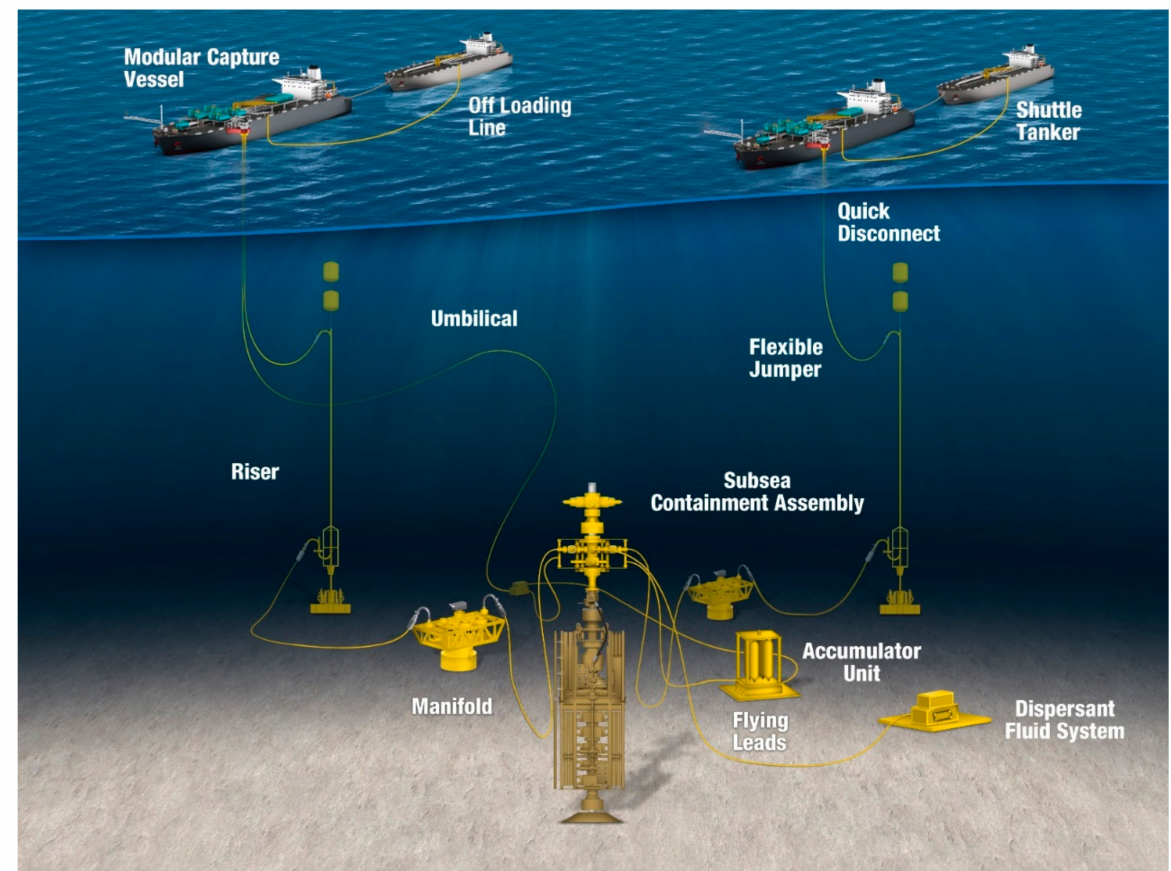
Figure 1. Deep-water facilities showing offshore platforms with the configurations for marine risers. Fluids are directed from the well to the Modular capture vessels (MCV) via flexible pipes and risers in a cap and flow system, which are part of an expanded containment system. (Courtesy: Marine Well Containment Company